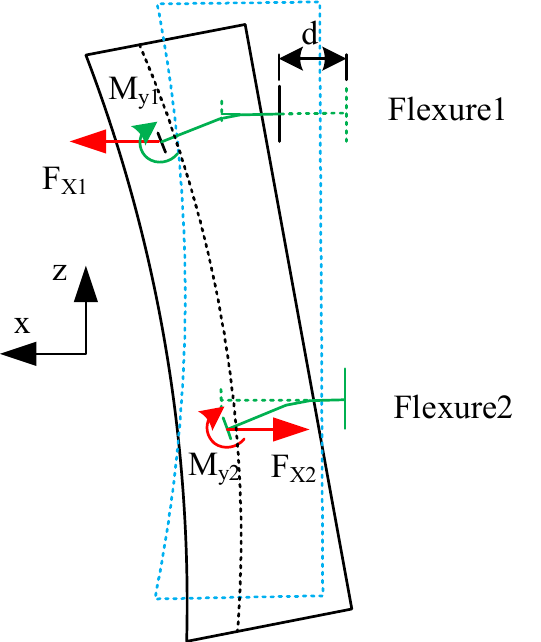
Figure 1. Schematic distribution of the transmitted loads under flatness error. In actual engineering, the causes of these four disturbances are different and approx- imately unrelated. The following error synthesis formula of random error and systematic error can be used to calculate the total error.